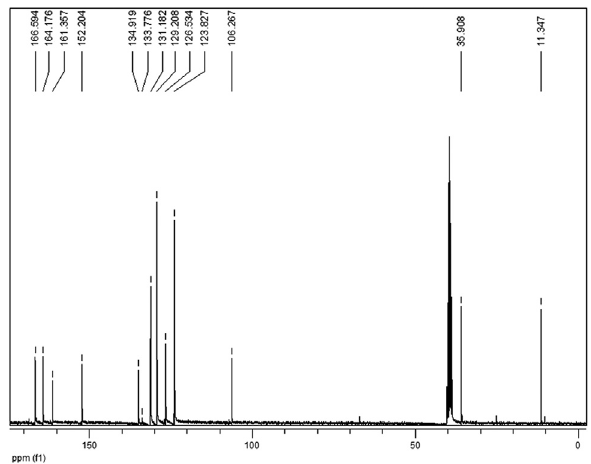
Figure 4 - 13 C RMN spectra of IR-01 in DMSO-d 6 at 75